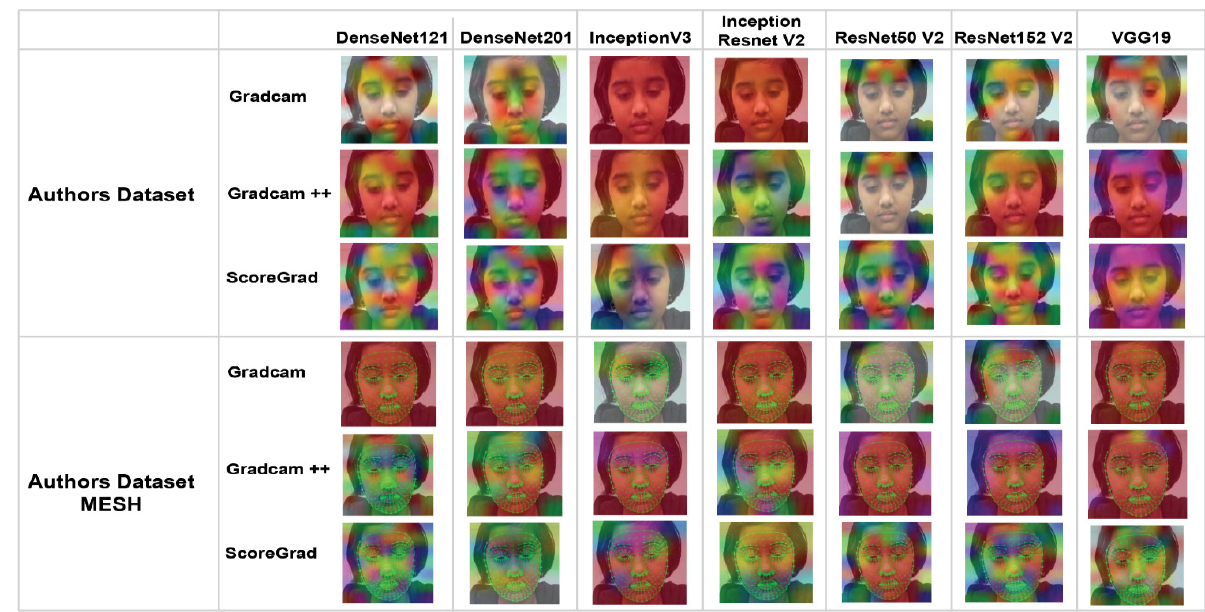
Figure 9. Saliency map of LIRIS dataset.